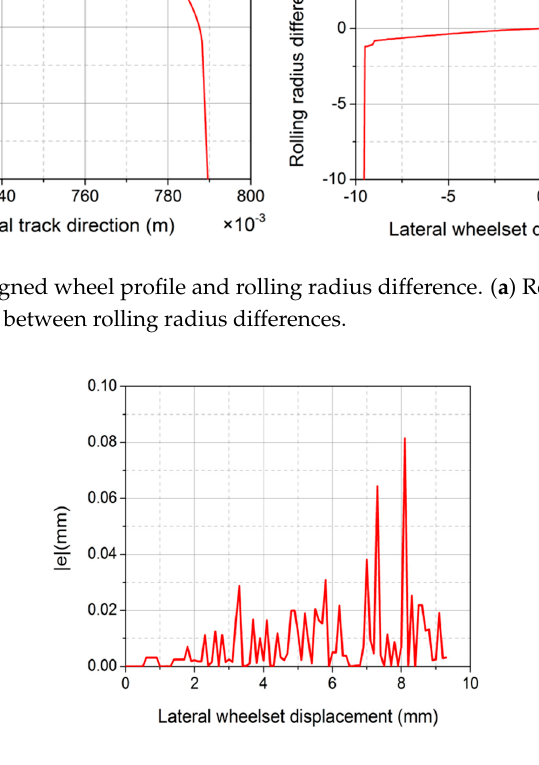
Figure 13. Absolute value of the error e in rolling radii difference distribution.